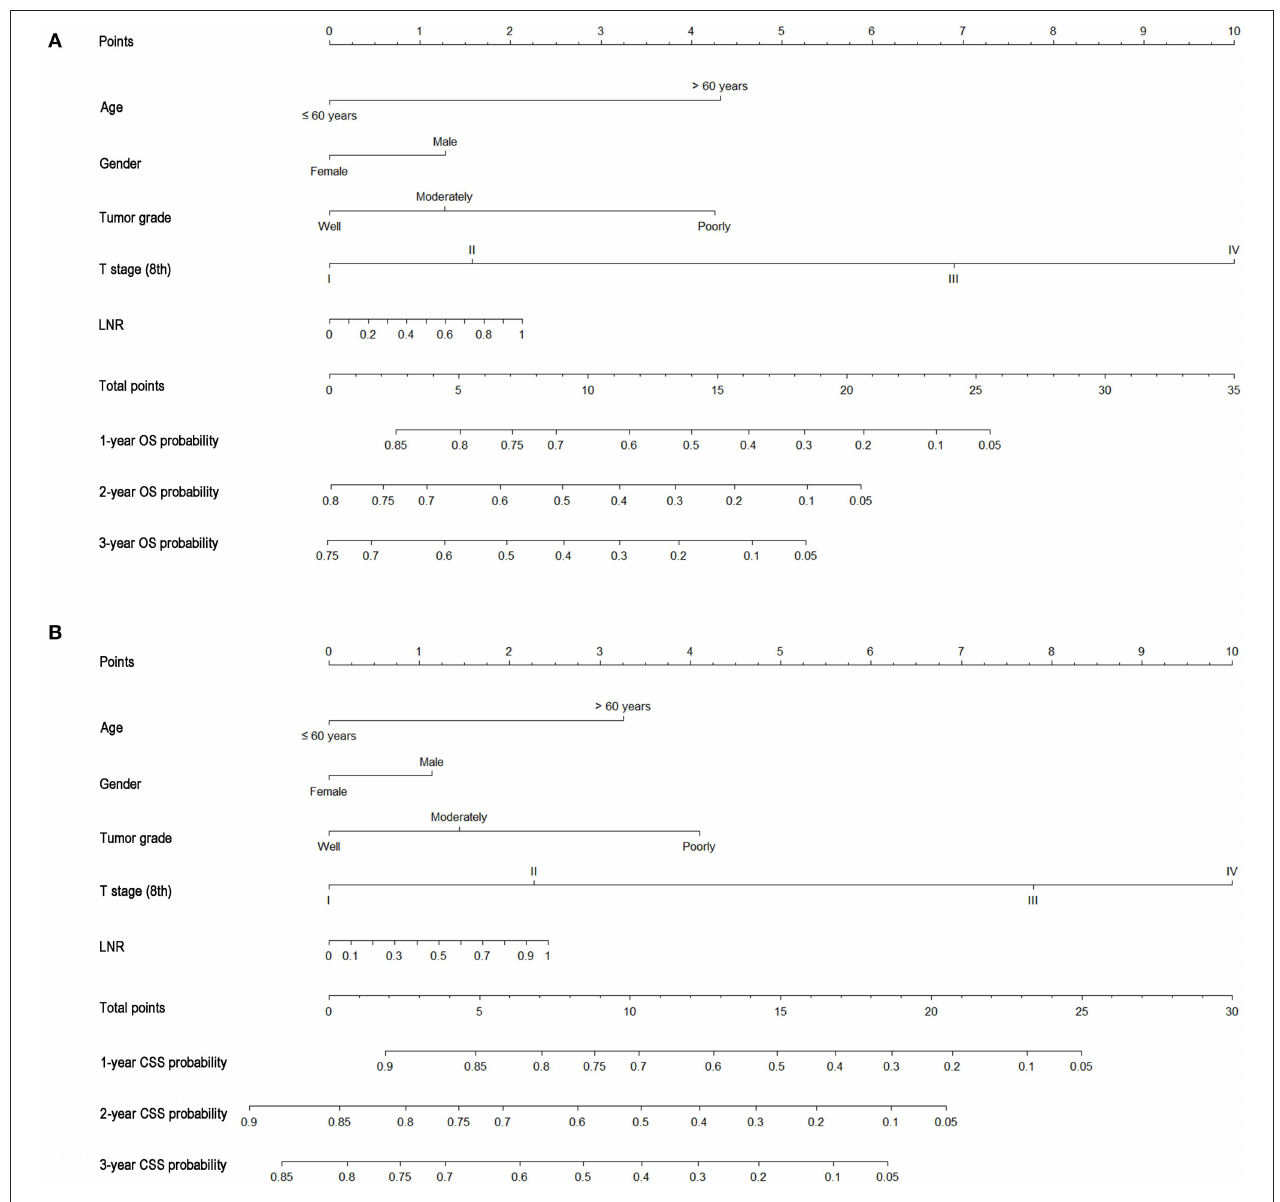
FIGURE 3 | Nomograms predicting 1-, 2-, and 3-year OS (A) and CSS (B) of patients with gallbladder carcinoma.